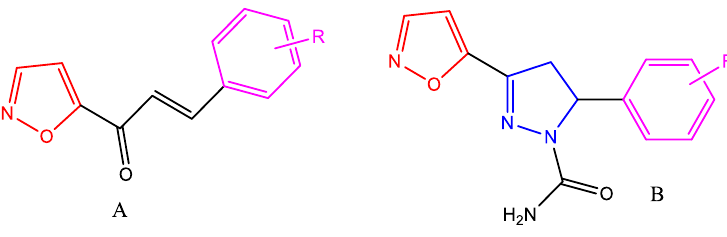
Figure 2. Previously designed isoxazole chalcone and dihydropyrazole derivatives.